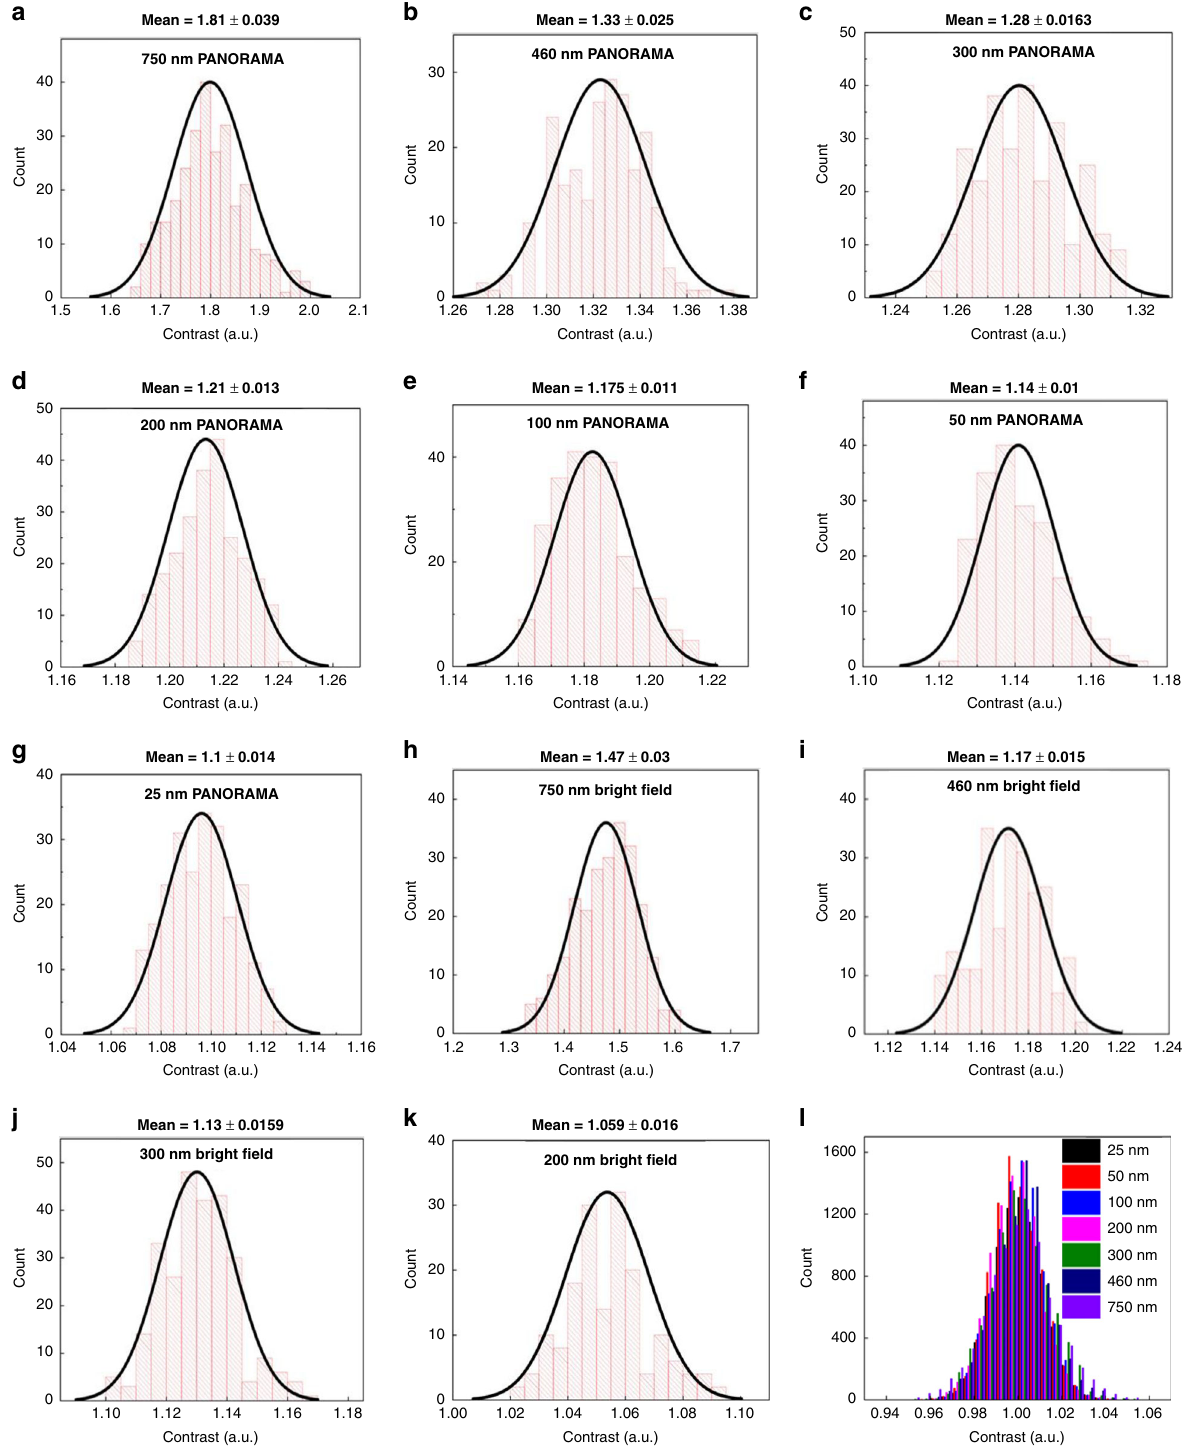
Fig. 2 Compiled IR histograms with the corresponding mean and standard deviation of detected particles via PANORAMA and bright- fi eld. Compiled IR histograms of detected PS beads by PANORAMA: a 750 nm ( n = 10), b 460 nm ( n = 5), c 300 nm ( n = 5), d 200 nm ( n = 5), e 100 nm ( n = 10), f 50 nm ( n = 5), and g 25 nm ( n = 10). Compiled IR histograms of detected particles by bright- fi eld: h 750 nm ( n = 10), i 460 nm ( n = 5), j 300 nm ( n = 5), and k 200 nm ( n = 5). l Corresponding IR histogram of the background from the squared regions in Fig. 1. Each particle size detection was repeated n times. All particles detected from all experiments ( n ) are used to plot the IR histogram and calculate the mean and standard